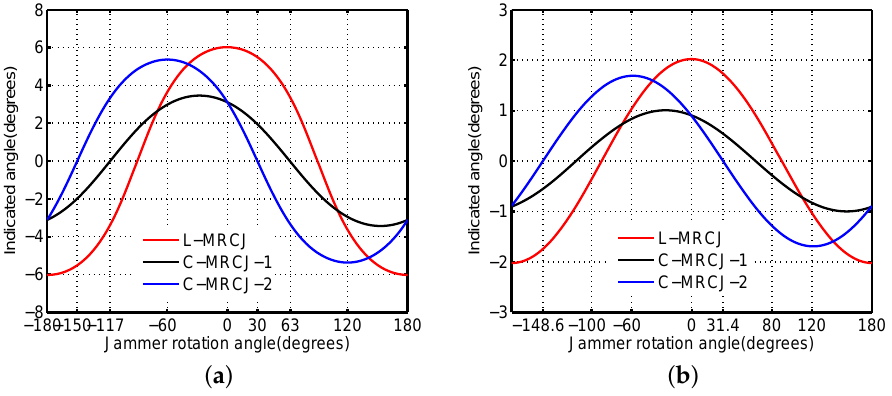
Figure 9. Monopulse-indicated angles of L-MRCJ and C-MRCJ when the jammer antennas rotate. ( a ) The system parameters are a 1 = a 2 = a 3 = − 0.5 dB, φ 1 = φ 2 = φ 3 = 180 ◦ . ( b ) The system parameters are a 1 = − 0.5 dB, a 2 = − 1.5 dB, a 3 = − 2.5 dB, φ 1 = 170 ◦ , φ 2 = 175 ◦ , φ 3 = 180 ◦